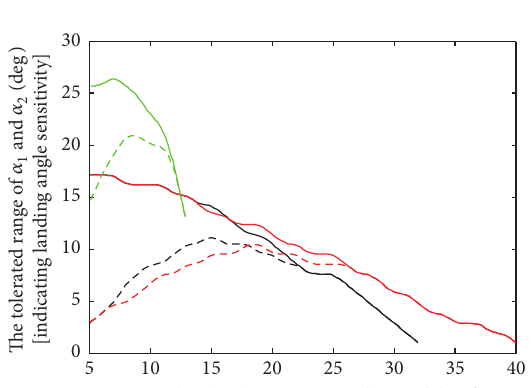
stiffnessTwo-segment leg model with constant spring stiffness Two-segment leg model with “J”-curve spring